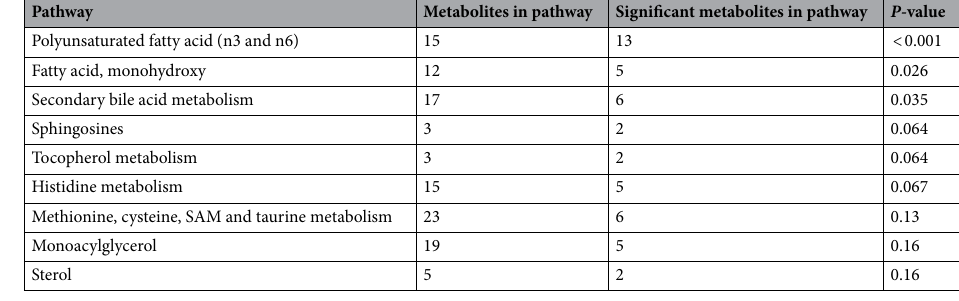
Table 1. Results of pathway enrichment analysis. Depicted are the top 9 sub-pathways with P ≤ 0.16 and at least two significant metabolites in pathway. SAM S-adenosylmethionine.